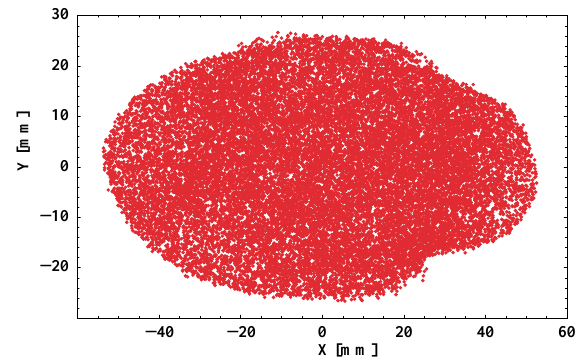
FIG. 20. (Color) ACCSIM run for the distribution with initial asymmetry. X - Y projection after 40 turns (working point with zero-current tunes 5.82, 5.75 ).